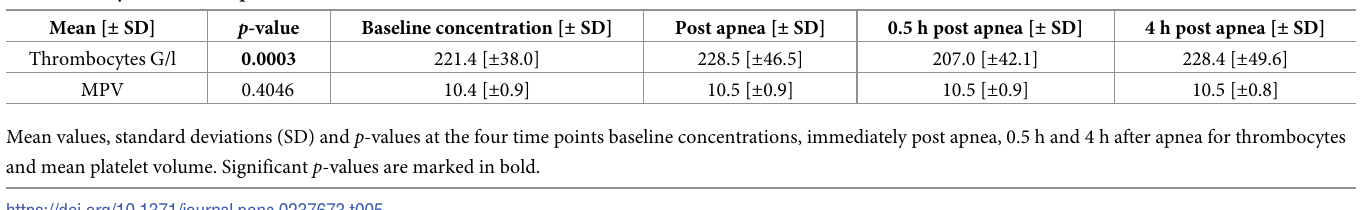
p -value 0.5 h post apnea vs. baseline concentration (mean value [CI])